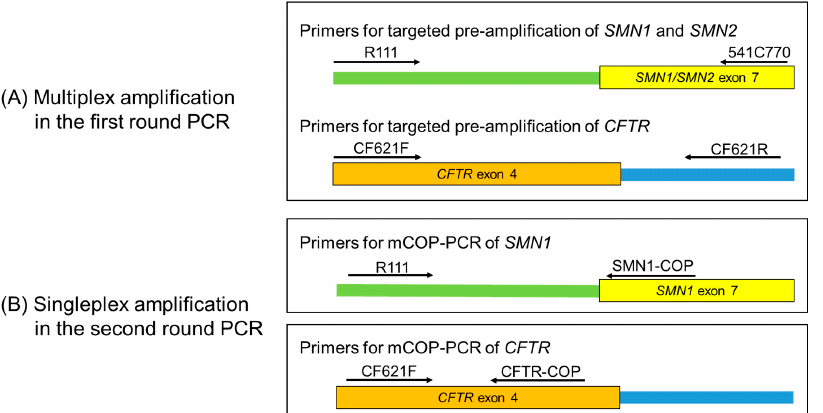
Figure 1. Primer positions used in the quantitative nested PCR. ( A ) Multiplex PCR in the first round of the nested PCR. Long SMN1, SMN2, and CFTR fragments were co-amplified by outer primers in a multiplex PCR. ( B ) Singleplex PCR in the second round of the nested PCR. Shorter fragments of SMN1 and CFTR were separately amplified in different tubes. Primer positions and directions are indicated